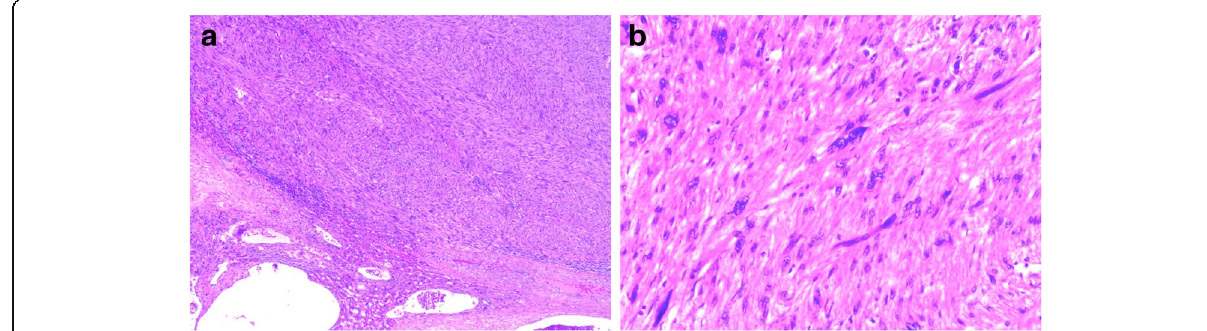
Fig. 5 In pathological findings, a the tumor consisted of bundle-like proliferation of complicated banding spindle-like cells with clear cytoplasm, accompanied by storiform pattern and compressed blood vessels. b Various degrees of nuclear atypia were observed, and nuclear fission images were demonstrated in 8/10 HPF